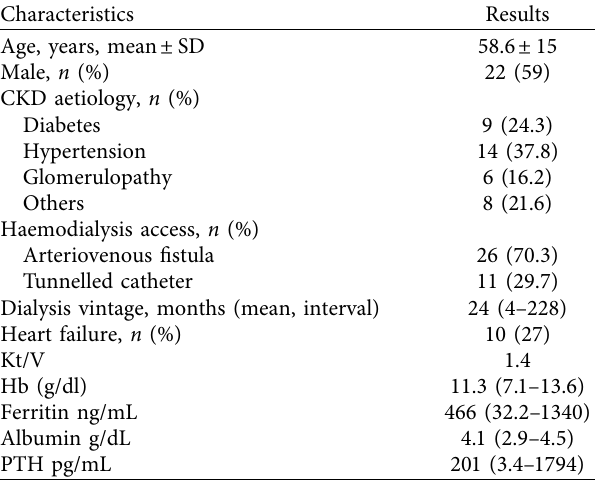
Table 1: Baseline characteristics of patients ( n � 37). Characteristics